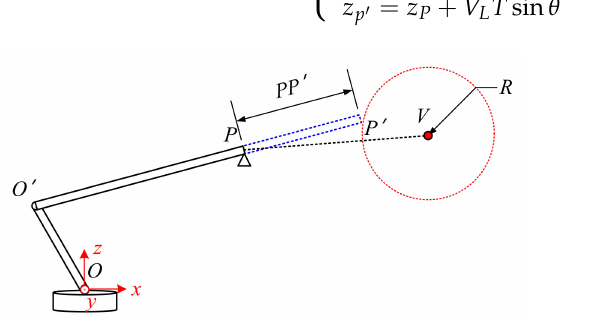
Figure 6. Collision urgency evaluation for stretching.